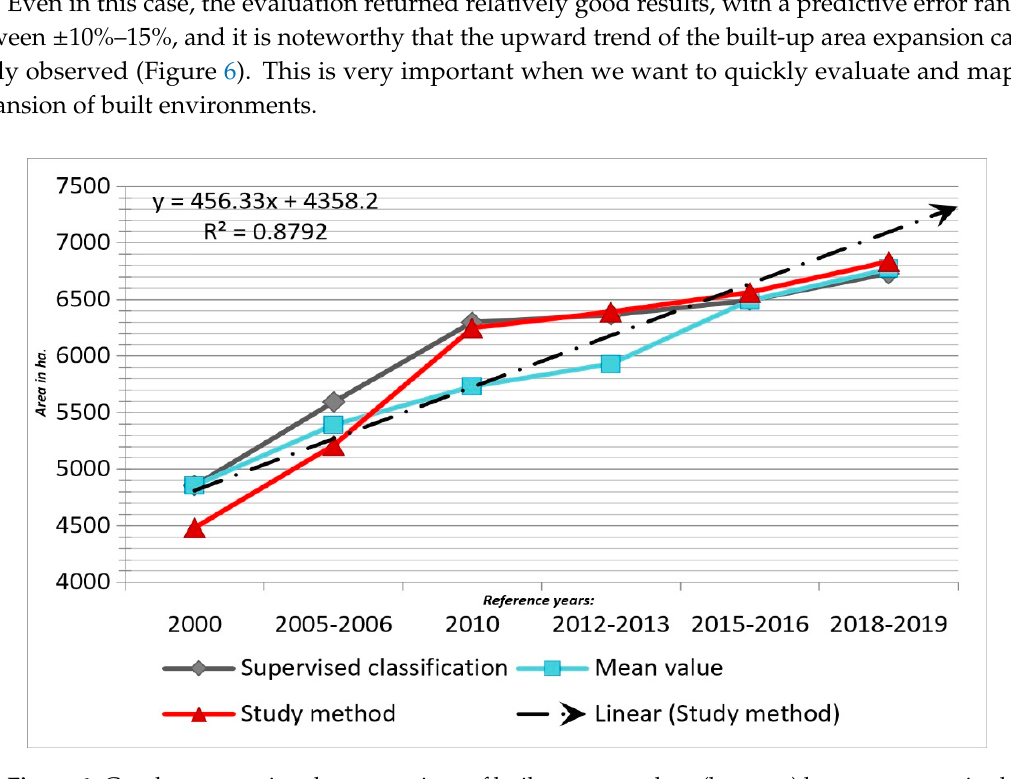
Figure 6. Graph representing the comparison of built-up area values (hectares) between supervised classification, mean value of other sources, and study method.